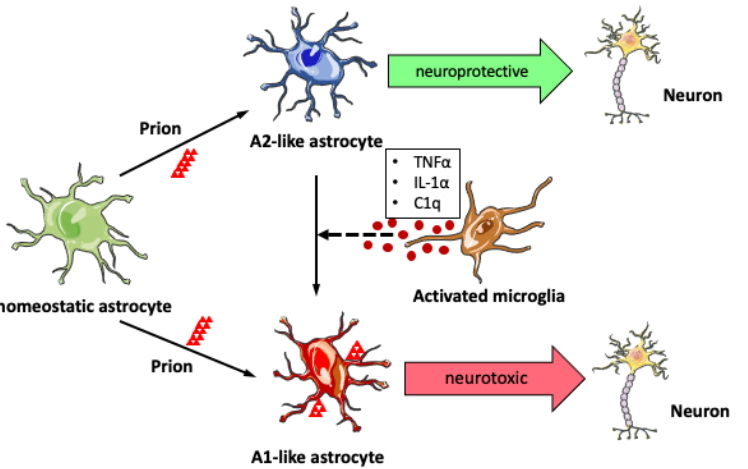
Figure 2. Astrogliosis in prion disease. Upon prion infection, astrocytes become activated into either the neuroprotective A2 phenotype or neurotoxic A1 phenotype. Heterogenous reactive astrocytes may coexist in prion-infected brains. Activated microglia release TNF α , IL-1 α , and C1q factors which in turn could trigger the transition from A2 to A1 phenotype. Reactive astrocytes can replicate and accumulate prions, and their aberrant phenotype with dysregulated signaling plays an overall neurotoxic role in prion